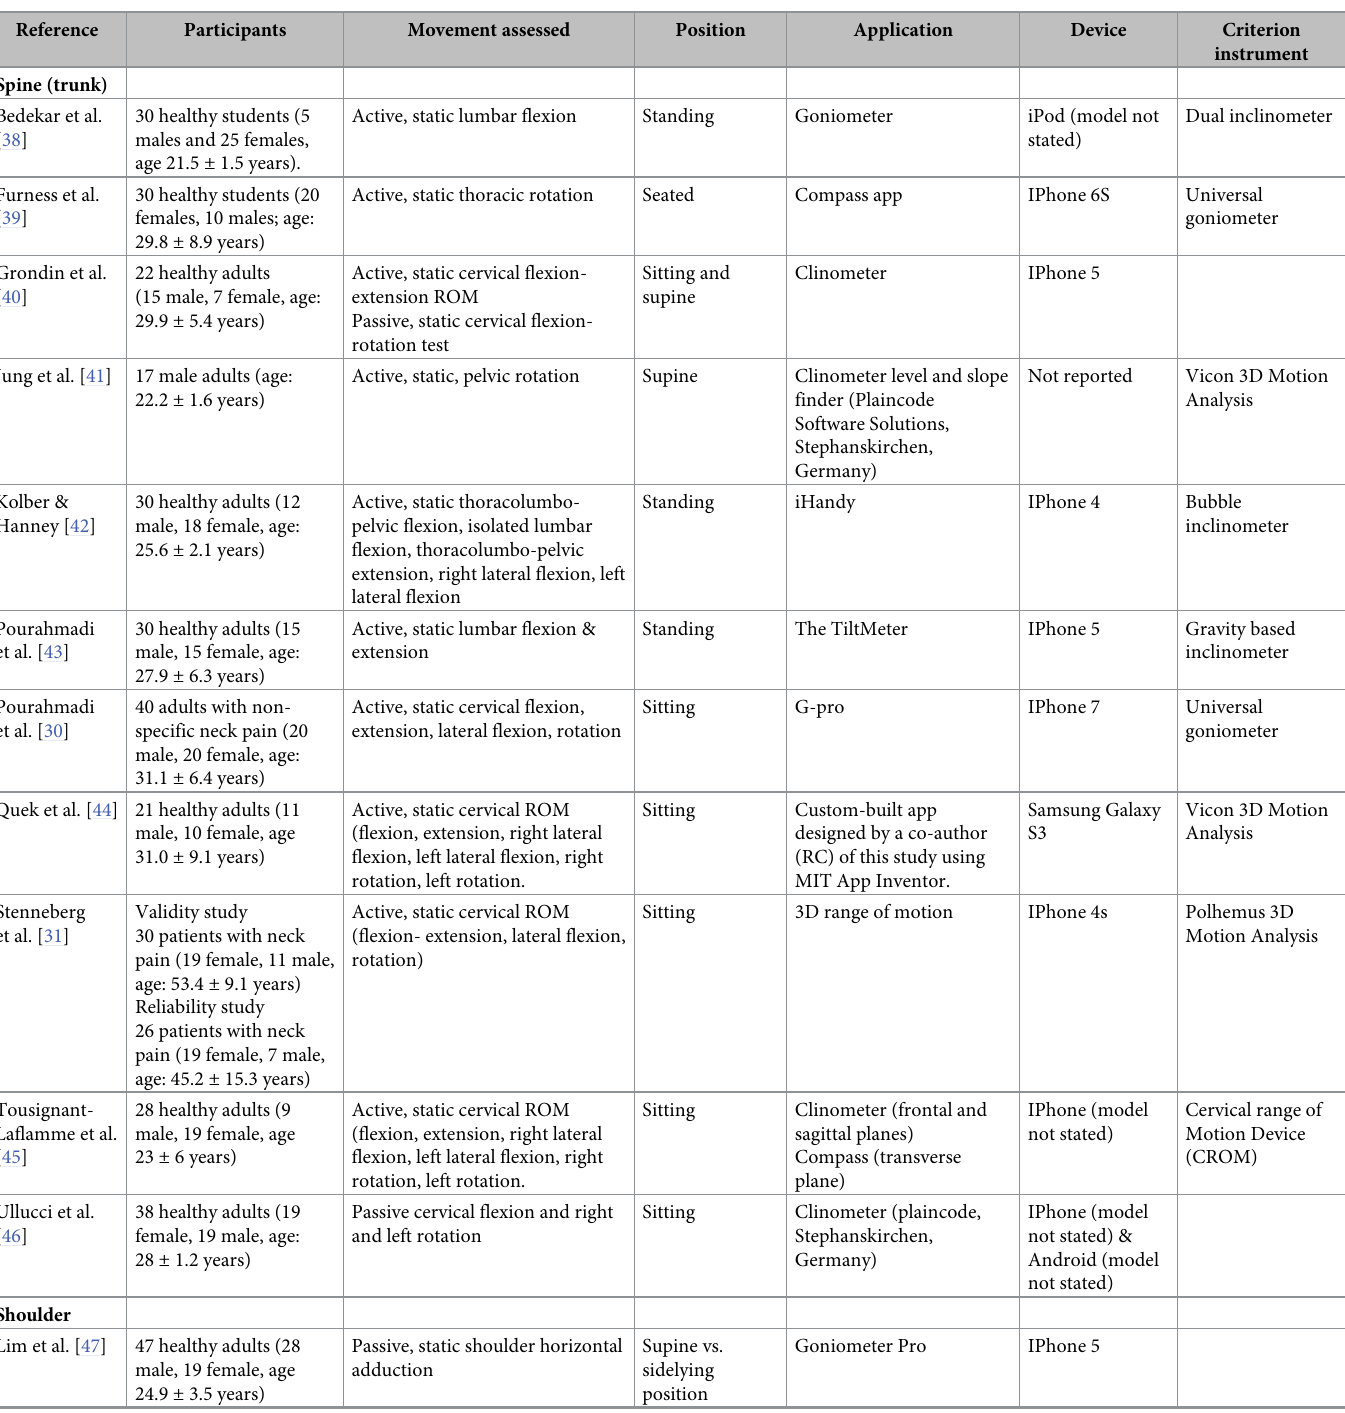
Table 1. Characteristics of studies included in this